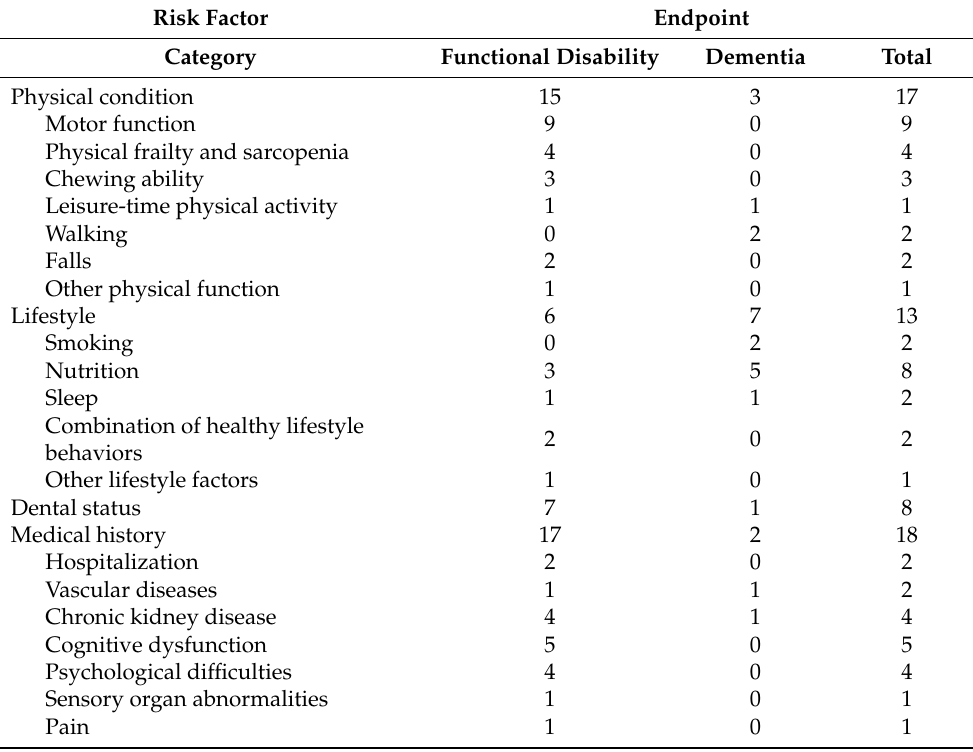
Table 2. Number of articles by combination of endpoint and risk